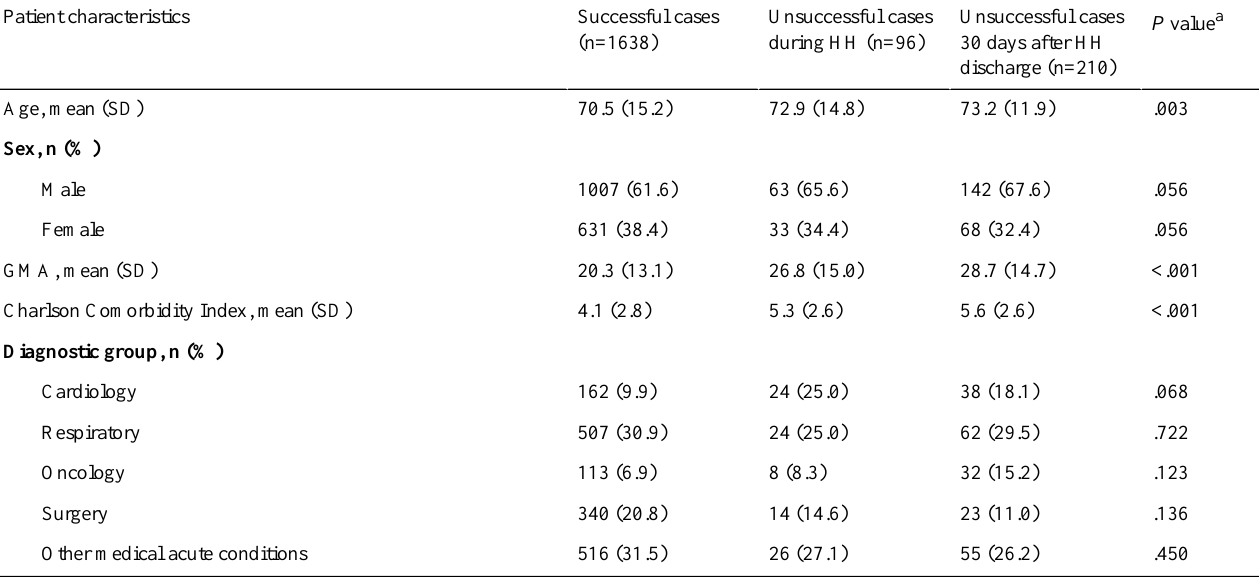
Table 2. Clinical characteristics of successful and unsuccessful home hospitalization (HH) cases (n=1925) based on re-admission.